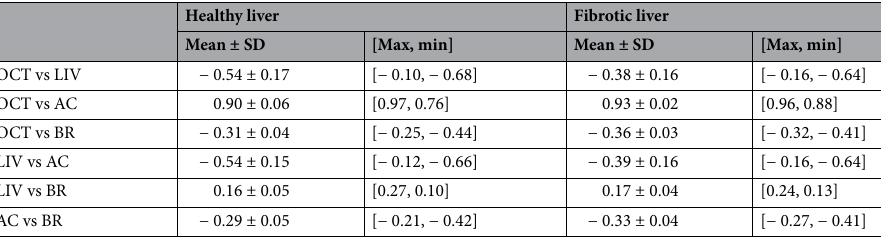
Table 1. Mean, standard deviation (SD), maximum (Max), and minimum (Min) values of the correlation coefficients between multiple contrasts including OCT, LIV, AC, and birefringence of the healthy and early fibrotic livers over all the time points. AC attenuation coefficient, LIV log-intensity variance, BR